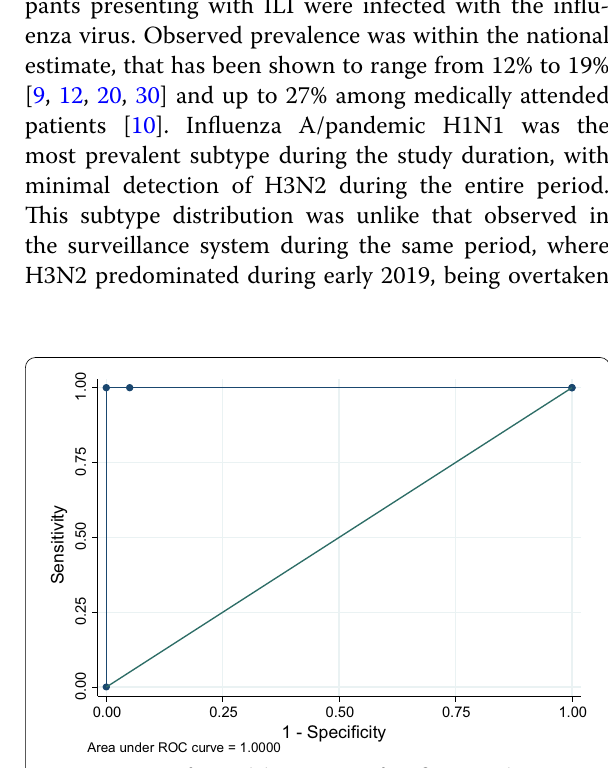
Fig. 1 ROC curve for rapid diagnostic test for Influenza with convectional RT–PCR as the gold